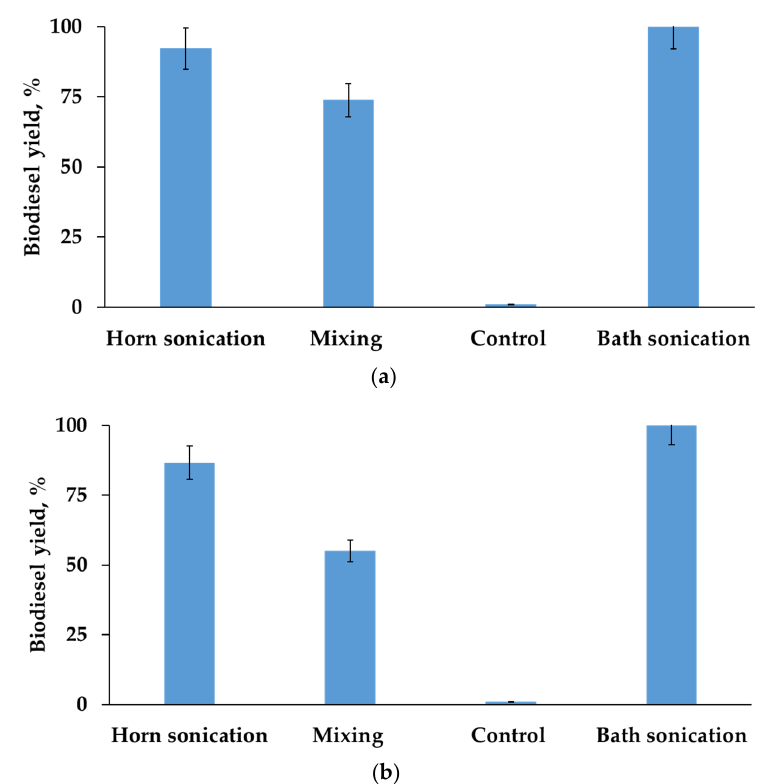
Figure 5. Effectiveness of brown grease esterification by methanol for 15 min at ambient temperature under different types of activation catalyzed by ( a ) 5.33% BF 3 and ( b ) 43.9 mg/mL AlCl 3 . Control— incubation of reaction mixture without any external